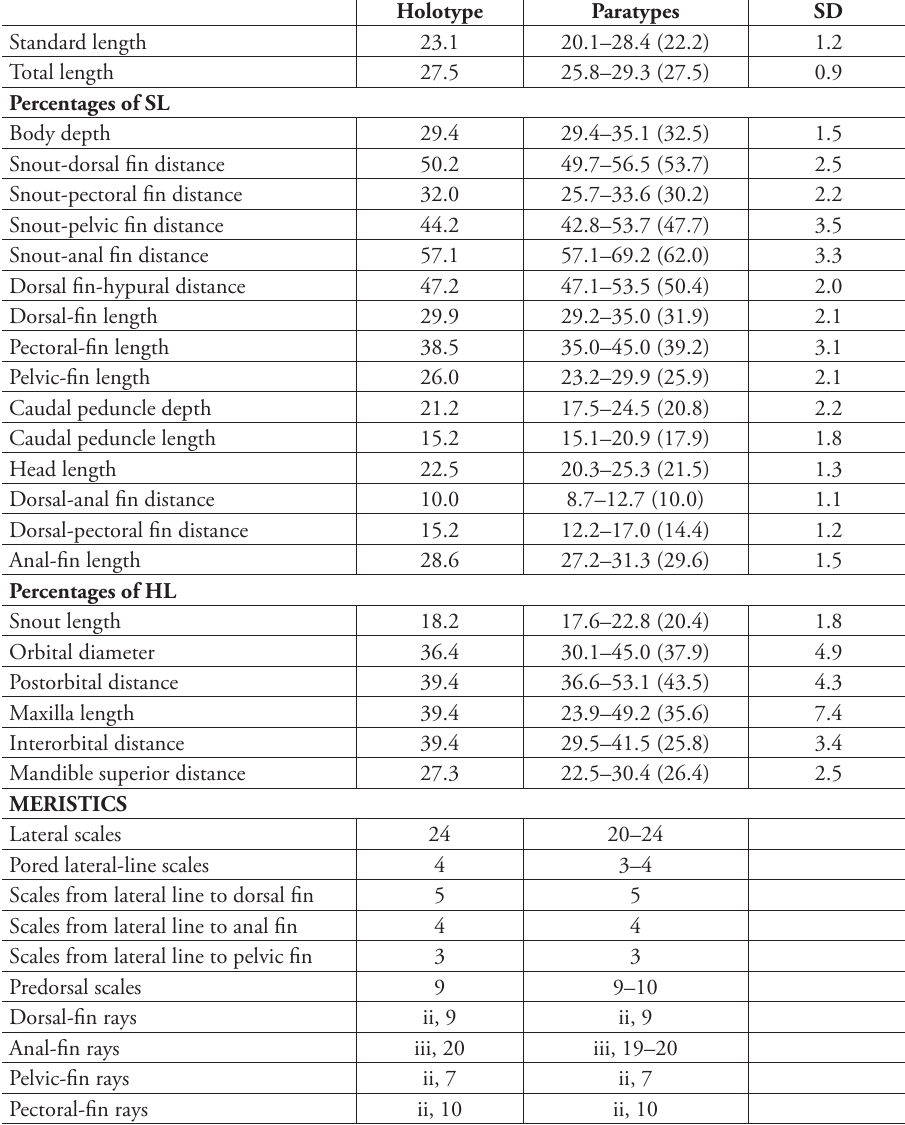
Table 1. Morphometric and meristic data of Hyphessobrycon klausanni sp. n. Standard length given in mm. Mean given in parentheses. SD = Standard